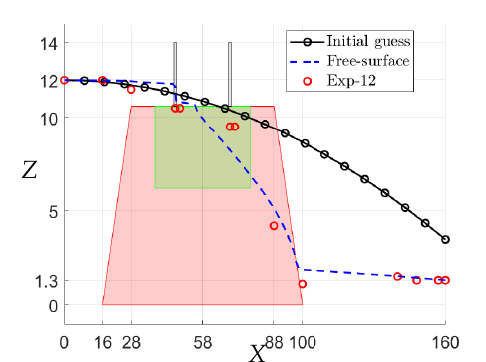
Figure 6. Free-surface of inflow at 10 cm with the convergence of free boundary by iterative algorithm.